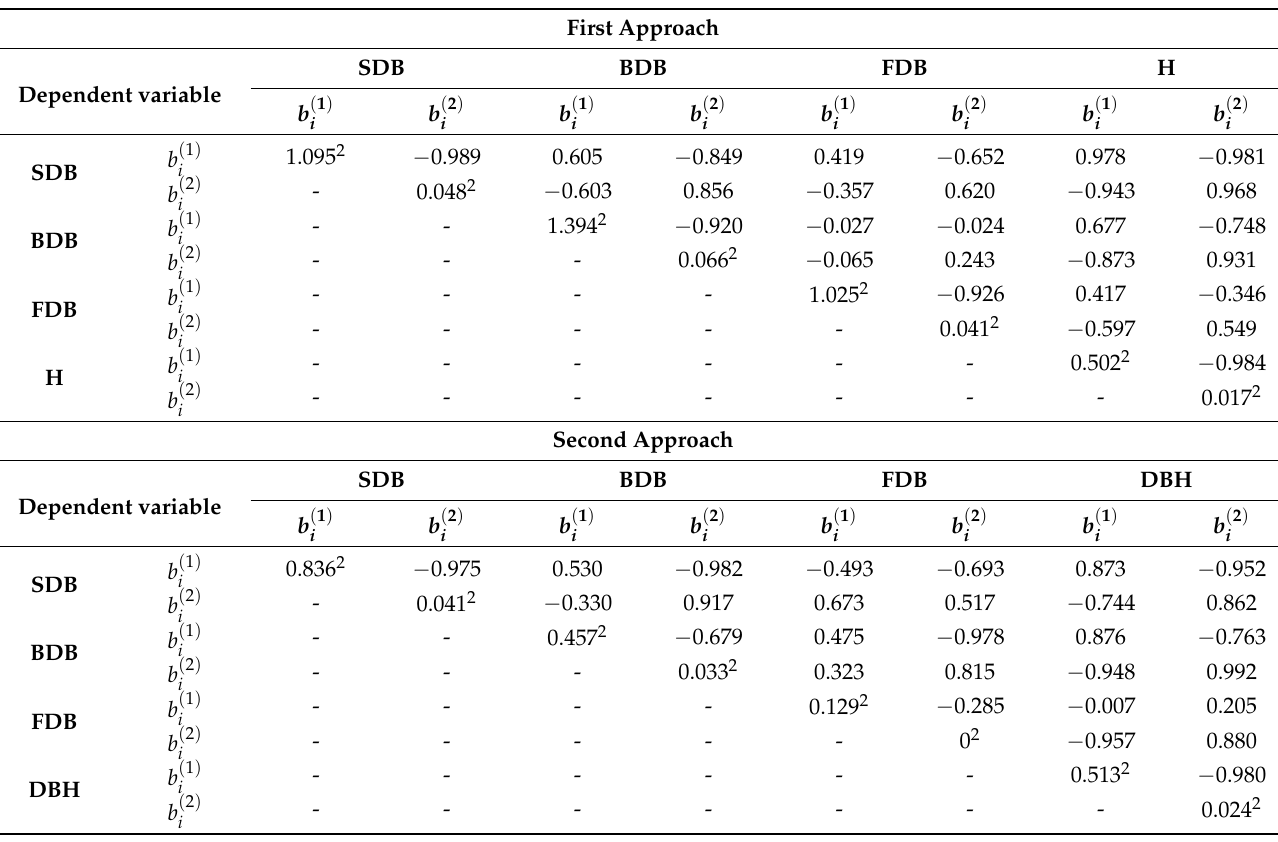
Table 4. Random-effects variance–covariance matrix for two approaches of seemingly unrelated mixed-effects model system. Matrix diagonal—variance, matrix upper triangle—correlation between random